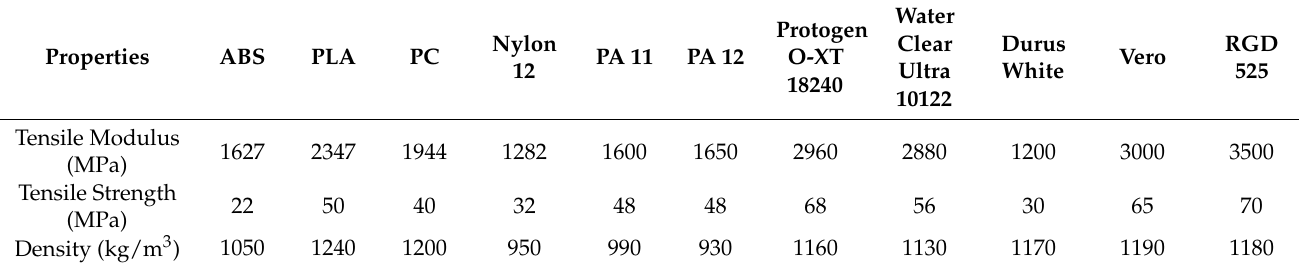
Table 2. Properties of commercial polymers used in additive manufacturing